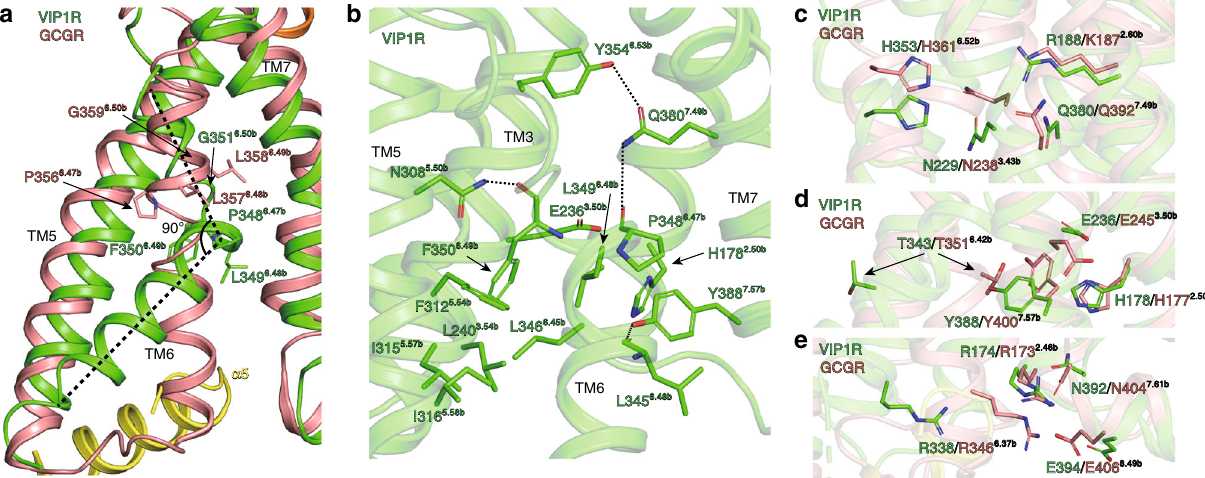
Fig. 4 Structure comparisons of active VIP1R with inactive GCGR. a The structural alignment of activated VIP1R with inactive GCGR showing the outward bending of the intracellular portion of TM6 of activated VIP1R, which results in a kink at the PxxG motif in TM6 and a ~90° angle between two portions of TM6 of the activated receptor. The TM6 kink in the active VIP1R structure is indicated by a dotted black line. The residues in the conserved PxxG motif in TM6 are shown in stick representation. b Polar and hydrophobic interactions that stabilize the kink at TM6 of activated VIP1R. The polar contacts are marked as black dotted lines. The positions of conserved polar residue networks located within VIP1R (green) and inactive GCGR (PDB code:4L6R, colored in salmon): central polar network ( c ), HETY network ( d ), and TM2 – 6 – 7 – helix 8 network ( e ). Side chains of the residues are shown in stick